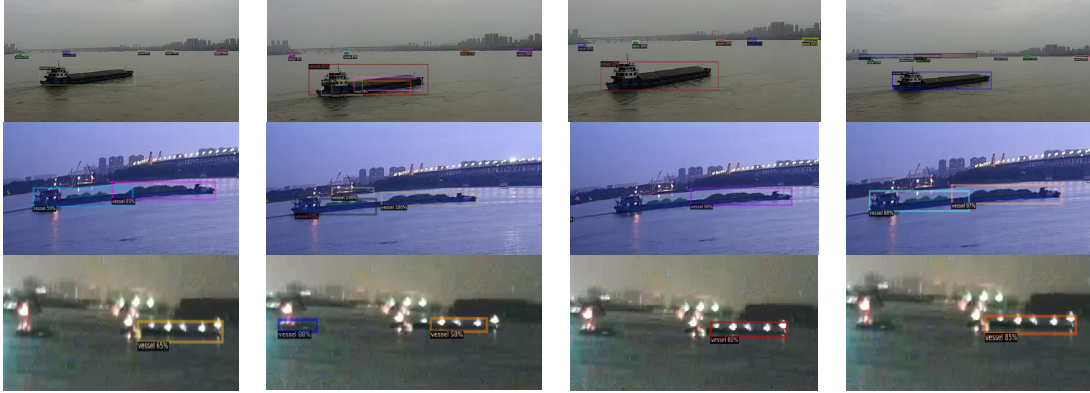
Figure 10. Visual comparison of detection results.